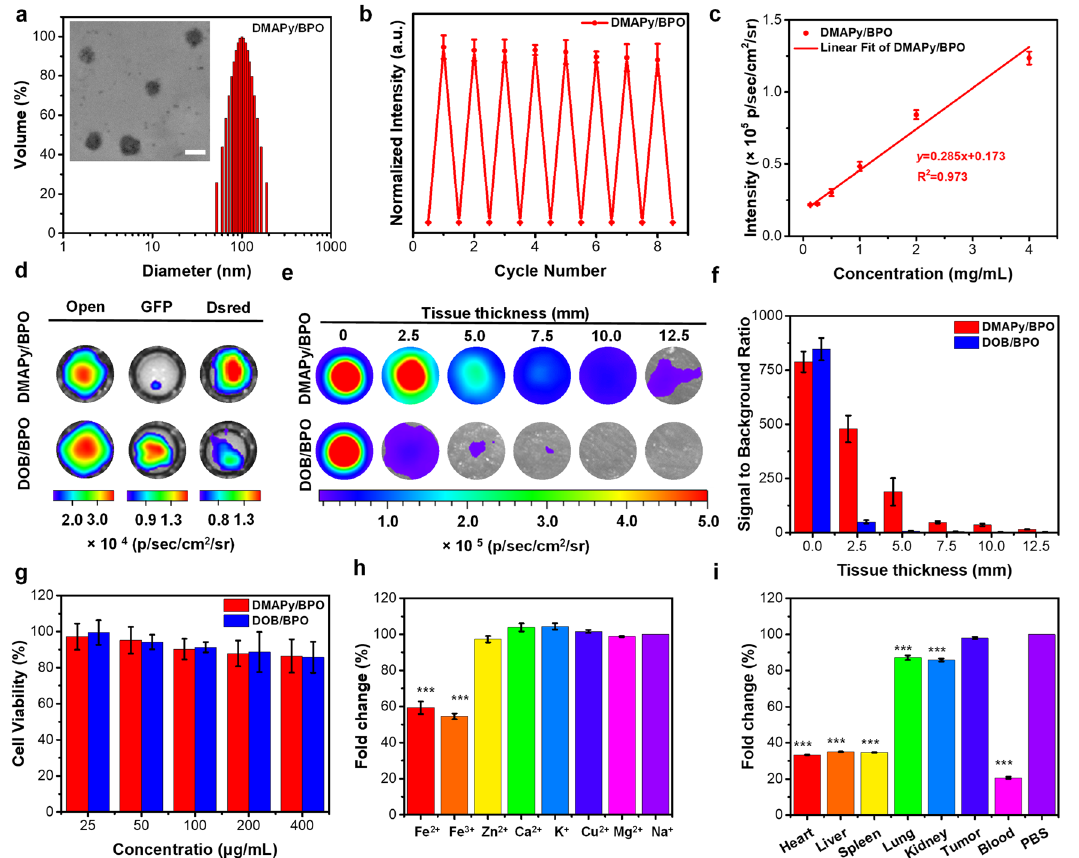
Fig. 6 Phosphorescence properties of DMAPy/BPO and DOB/BPO nanoparticles. a Diameter distribution of DMAPy/BPO nanoparticles. Inset: transmission electron microscopy image, scale bar = 100 nm. b The normalized phosphorescence intensities of DMAPy/BPO NPs as a function of cycle number of UV light irradiation ( n = 3). c The phosphorescence intensities as a function of the concentration of DMAPy/BPO NPs ( n = 3). d Phosphorescence images of DMAPy/BPO and DOB/BPO NPs (4 mg mL − 1 ) were captured through different fi lters. e Phosphorescence images of DMAPy/ BPO and DOB/BPO NPs (10 mg mL − 1 ) covered with different thicknesses of chicken tissue. f SBR ratios from coverings with different tissue thicknesses given in ( e ). g Cytotoxicities of DMAPy/BPO and DOB/BPO NPs against 4T1 cells. The 4T1 cells were incubated with DMAPy/BPO and DOB/BPO NPs at different concentrations for 8 h ( n = 4). h Fold change plot of phosphorescence intensities of DMAPy/BPO NPs in various metal ions. Error bars: mean ± standard deviation ( n = 3). Triple asterisks represent p < 0.01 compared with Na + . i Fold change plot of phosphorescence intensities for DMAPy/ BPO NPs in different tissue homogenates. Error bars: mean ± standard deviation ( n = 3). Triple asterisks represent p < 0.01 compared with